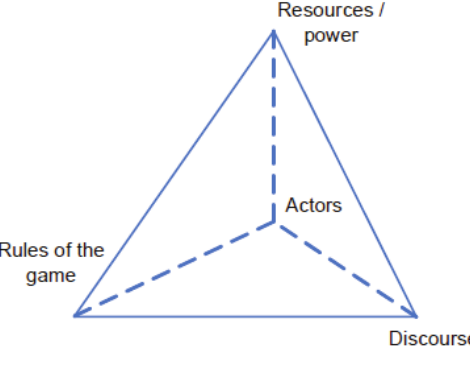
Figure 1 Tetrahedron of the Policy Arrangement Approach 71